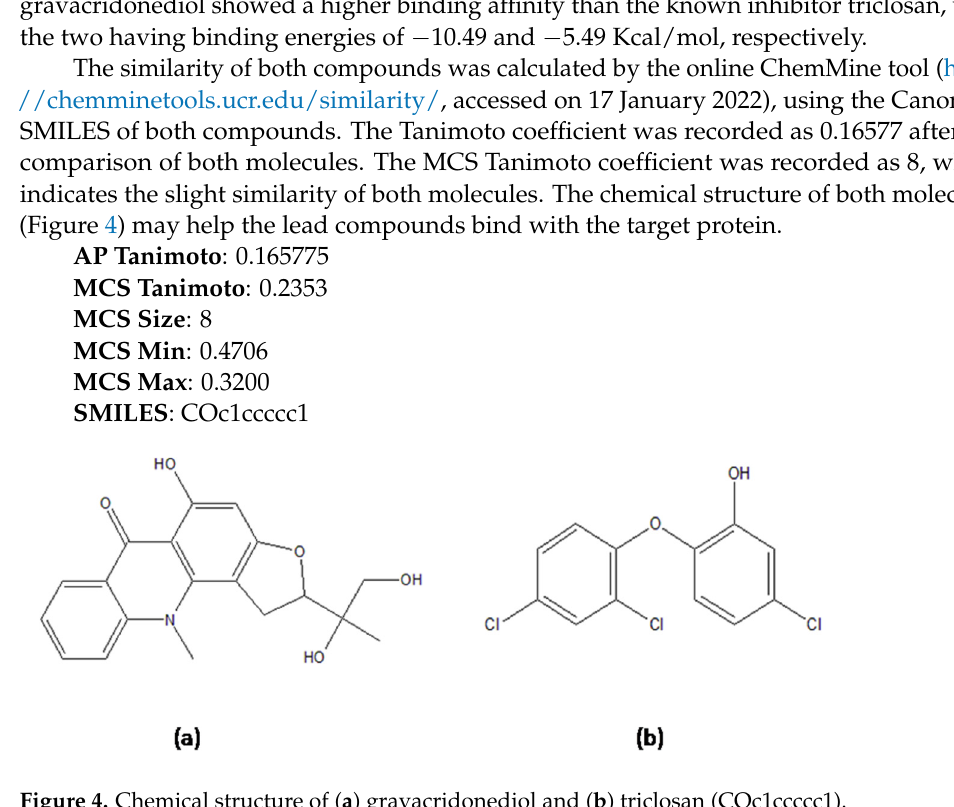
Figure 4. Chemical structure of ( a ) gravacridonediol and ( b ) triclosan (COc1ccccc1). Gravacridonediol=C1=CC(=C(C=C1Cl)O)OC2=C(C=C(C=C2)Cl)ClC1=CC(=C(C=C- Gravacridonediol=C1=CC(=C(C=C1Cl)O)OC2=C(C=C(C=C2)Cl)ClC1=CC(=C(C=C1 Cl)O)OC2=C(C=C(C=C2)Cl)Cl Triclosan= CC(CO)(C1CC2=C(O1)C=C(C3=C2N(C4=CC=CC=C4C3=O)C)O)O